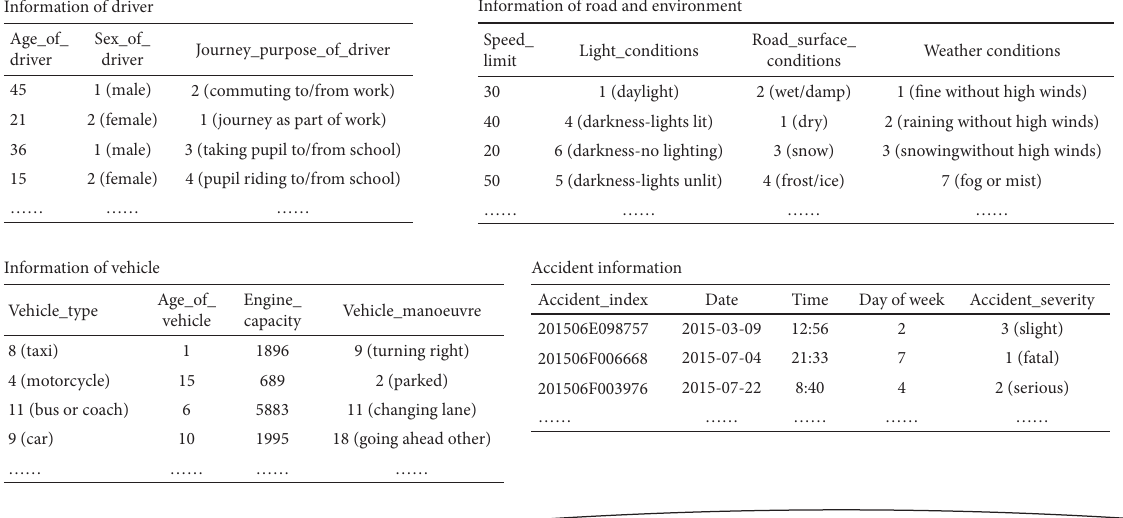
Figure 1: Structure of the road safety dataset of the United Kingdom.